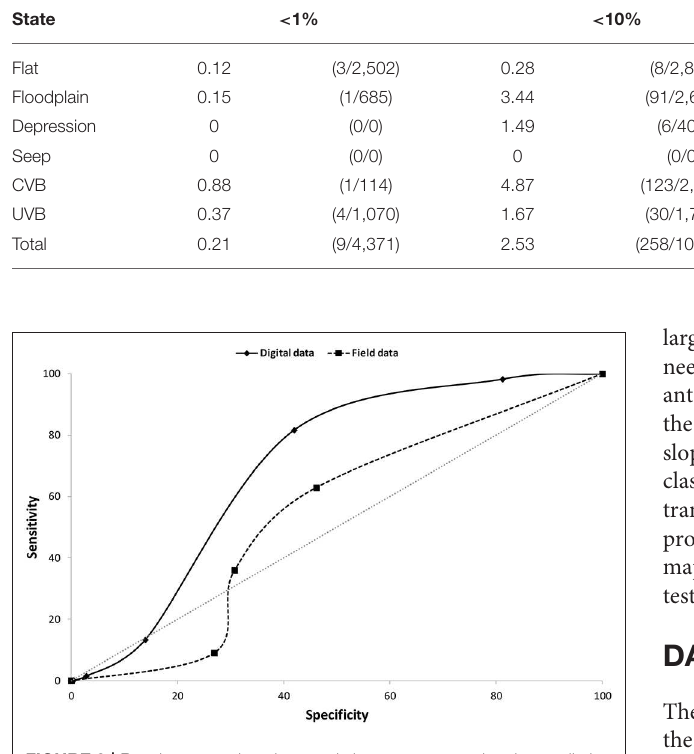
wetlands, followed by classifying the remaining wetlands